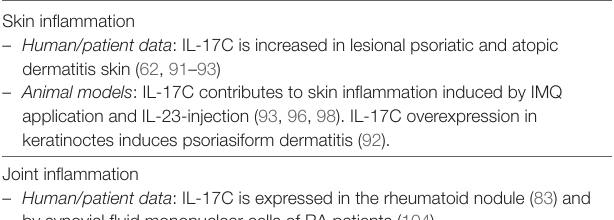
TABLe 6 | Overview of the role exerted by IL-17E in inflammation. Skin inflammation – Human/patient data : IL-17E is increased in the lesional skin of psoriasis, atopic dermatitis, and contact dermatitis (43, 111–115) Joint inflammation – Human/patient data : IL-17E is increased in the serum and synovial fluid of RA patients (116, 117) – Animal models : IL-17E attenuates CIA development (117) Gut inflammation – Human/patient data : IL-17E is downregulated in patients with IBD (118) – Animal models: 17E was found to either ameliorate or aggravate colitis in mice depending on model (118, 119) CNS – Animal models : IL-17E suppresses Th17 immune responses in EAE (120) Cardiovascular disease – Animal models : IL-17E inhibits atherosclerosis development (121, 122) CNS, central nervous system; RA, rheumatoid arthritis; CIA, collagen-induced arthritis; IBD, inflammatory bowel disease; EAE, experimental autoimmune encephalomyelitis.